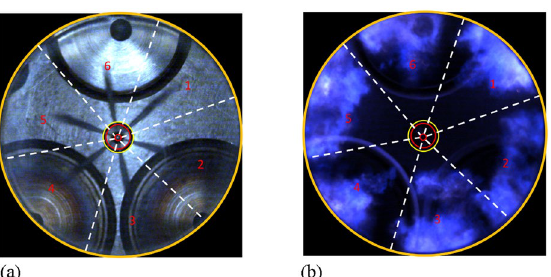
Figure 3. Raw images of the ( a ) pilot diesel spray and ( b ) tri-fuel natural flame